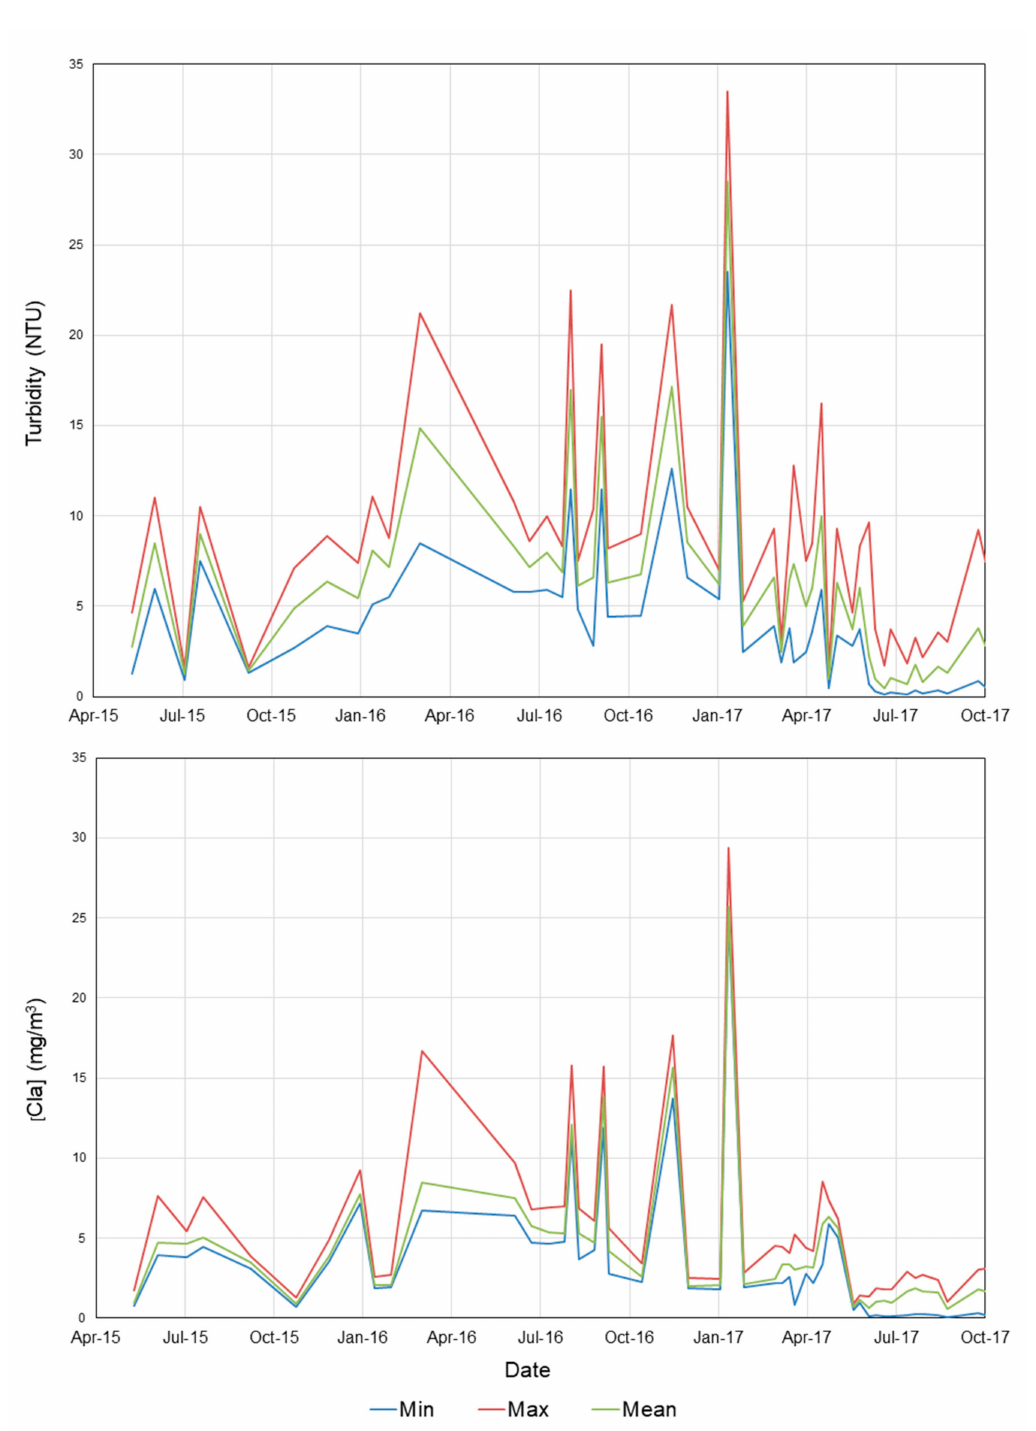
Figure 6. Time series of the maximum, minimum, and mean values of water parameters, estimated from satellite